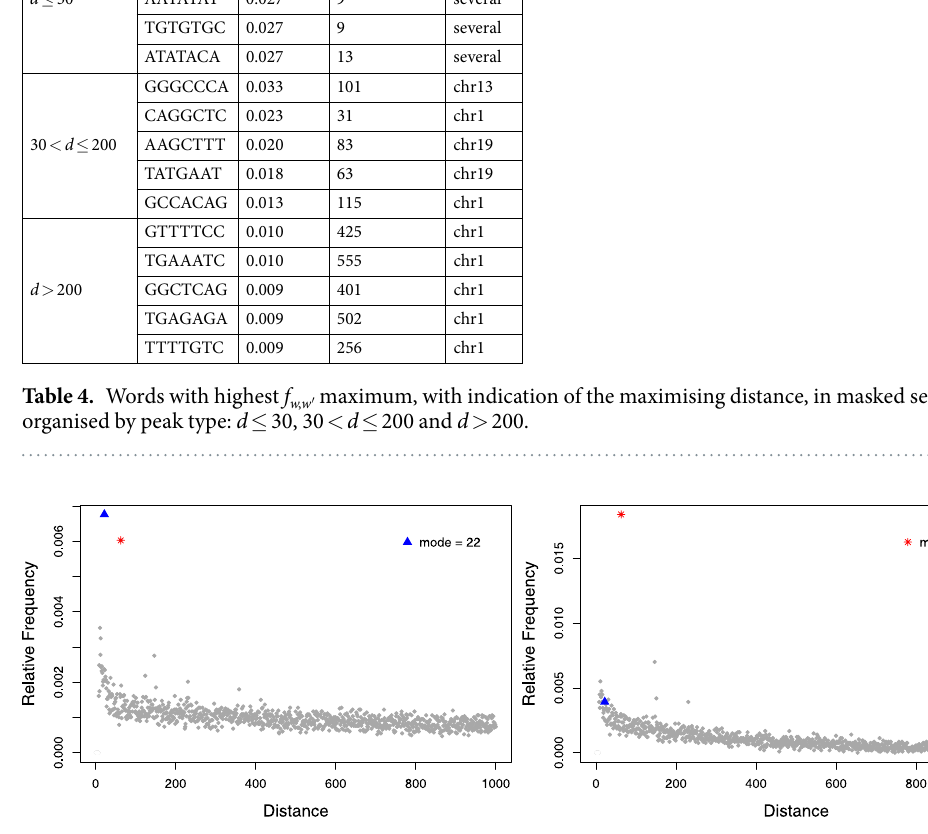
Figure 7. DNRC distribution f w , w ′ for w = TATGAAT in the complete genome (left) and in the repeat-masked genome (right). The triangle symbol identifies the mode in the complete genome ( d = 22) and the asterisk symbol is the mode in the masked genome ( d =